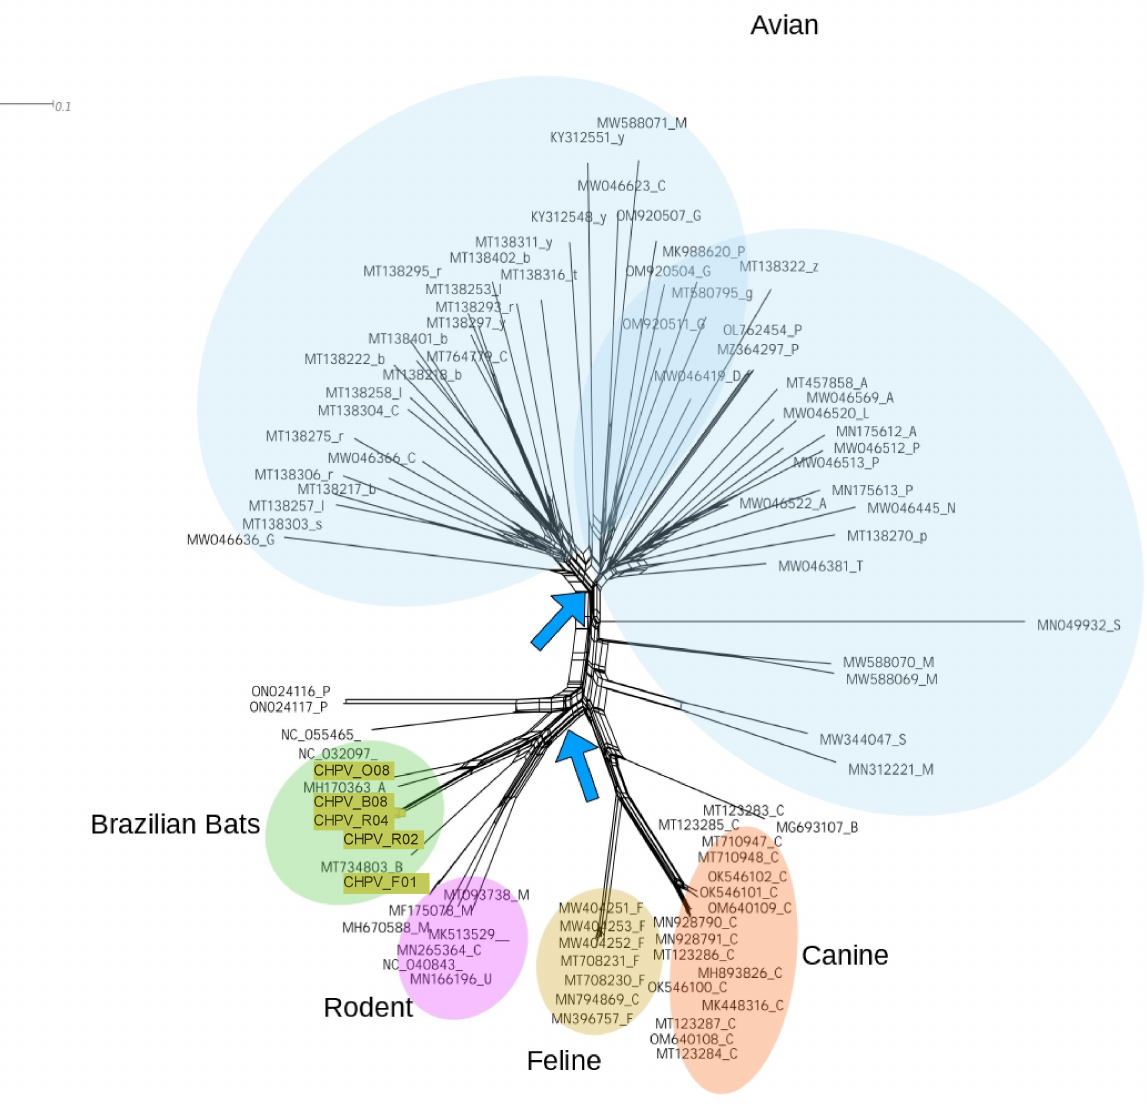
Figure 5.Figure 5. Network graph of the NS1 genomic region of CHPV. The diagram shows a network clustering similar sequences. The main clusters are indicated by different colors. Sequences from this study are highlighted. Arrows indicate reticulated edges connecting sequences.